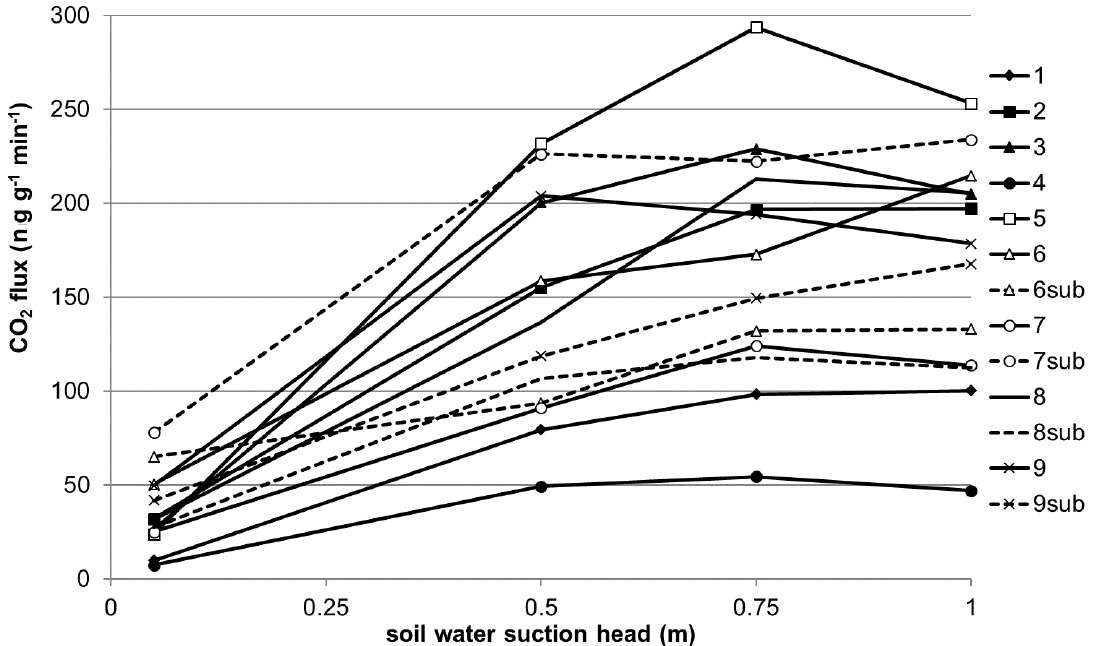
Figure 2. Carbon dioxide emission rates (ng g -1 min -1 ; dry mass basis) from the 13 soils at suction heads of 0.05 (near water-saturated), 0.5, 0.75 and 1.0 m water column. Data for topsoils are indicated by solid lines and those for subsoils (Sites 6–9 only) by dashed lines. For 0.75 m suction head, n = 3; for all other suction heads, n =